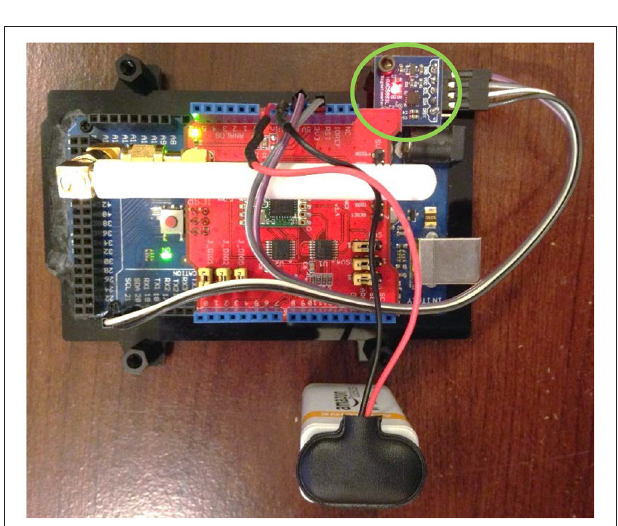
FIGURE 2 | Arduino Mega with HMC5883L magnetometer (circled in green) and LoRa